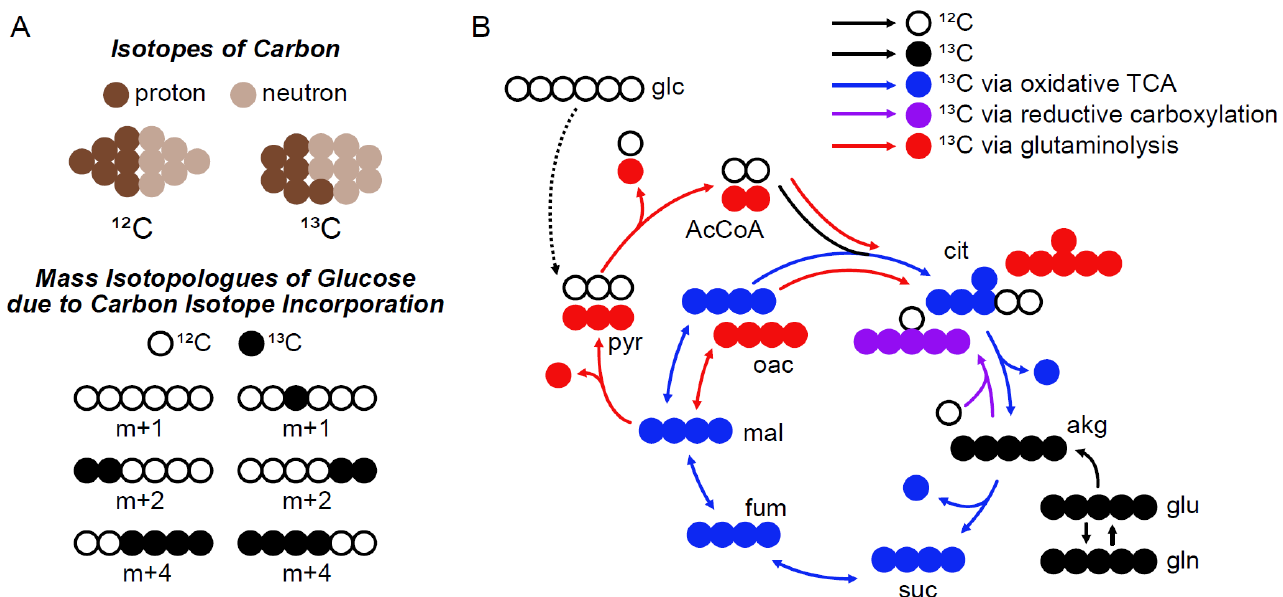
Figure 1. Principles of Stable-Isotope Tracing. ( A ) Isotopes of an element are atoms of that element with different masses due to the number of neutrons they contain. Each element has a characteristic isotope mass distribution (IMD) describing the proportion of the atoms having the nominal mass (m) and those greater than nominal mass by n integer atomic mass units (m + n). Mass isotopologues of a compound are molecules of that compound with different masses due to the number of heavy isotopes they contain. Each compound has a mass isotopologue distribution (MID) describing the proportion of molecules having the monoisotopic mass (m) and those greater than the monoisotopic mass by n integer atomic mass units (m + n). Molecules of mass m have no extra neutrons due to heavy isotope incorporation while those of mass m + n have n extra neutrons due to heavy isotope incorporation. ( B ) Schematic of possible TCA cycle metabolite labeling patterns due to incorporation of 13 C from a [U- 13 C 5 ]glutamine